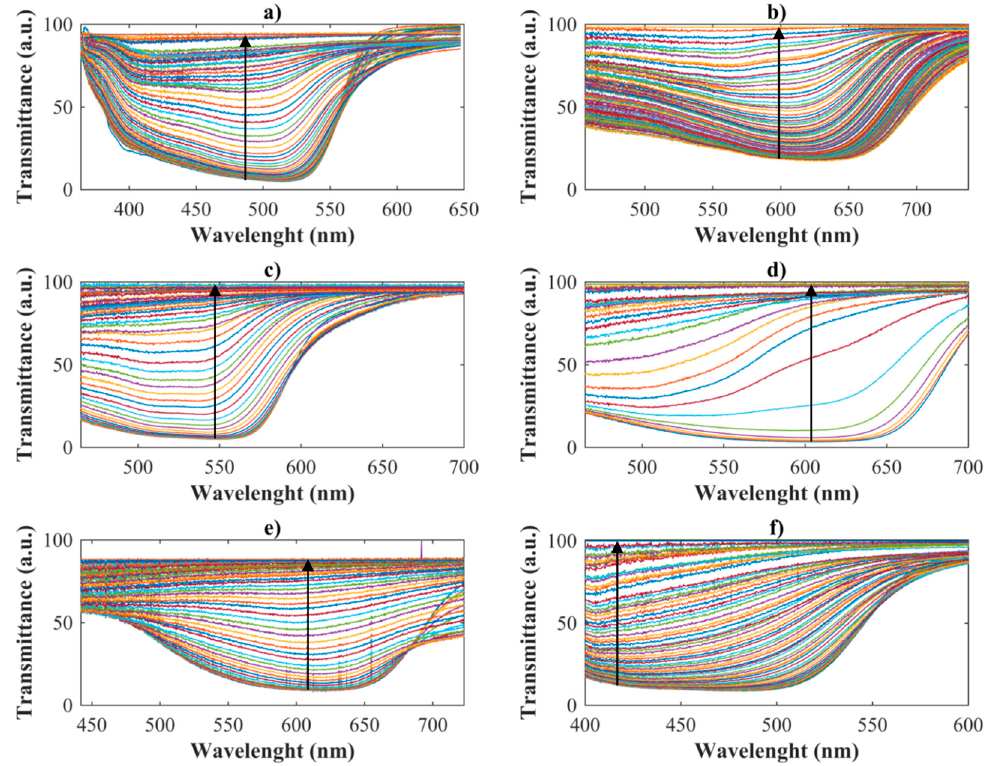
Figure 3. Transmittance of each dye. ( a ) OP2, ( b ) RB, ( c ) PC, ( d ) PN, ( e ) PB, ( f ) PY.